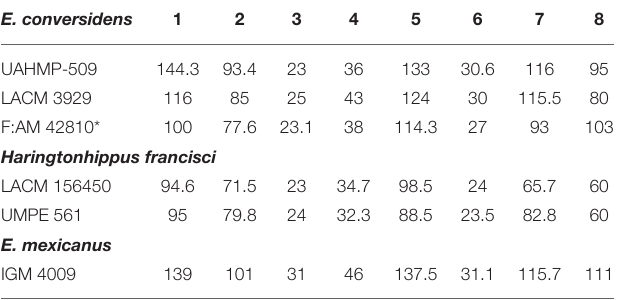
Numberofmeasurementsasin Figure 2 .Measurement8isthewidthbetweenbeginning of the sagittal crest to the external part of the temporal articular tubercle. * Measurements taken from the image of Eisenmann